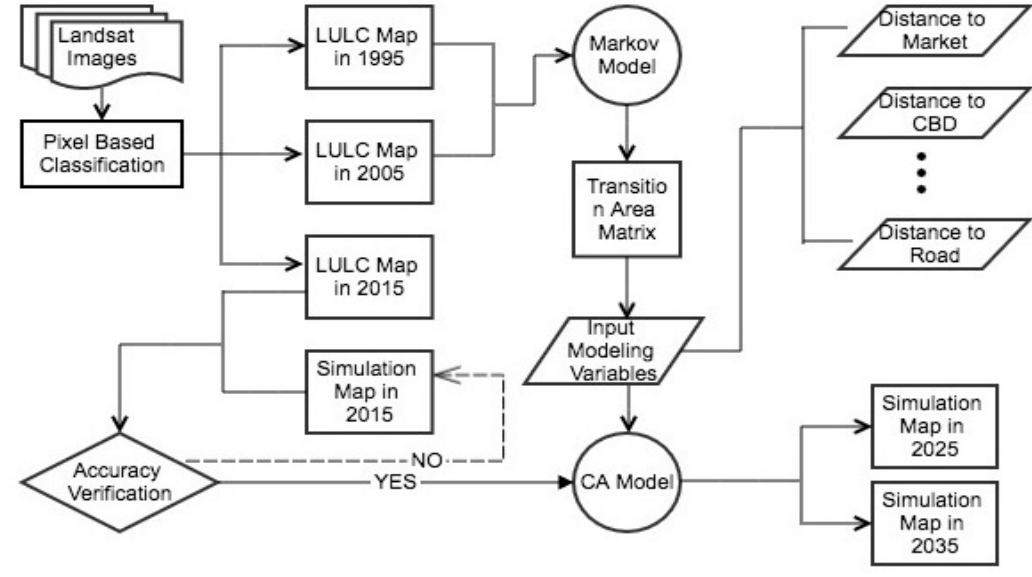
Figure 3. Process of simulation in urbanization modeling.